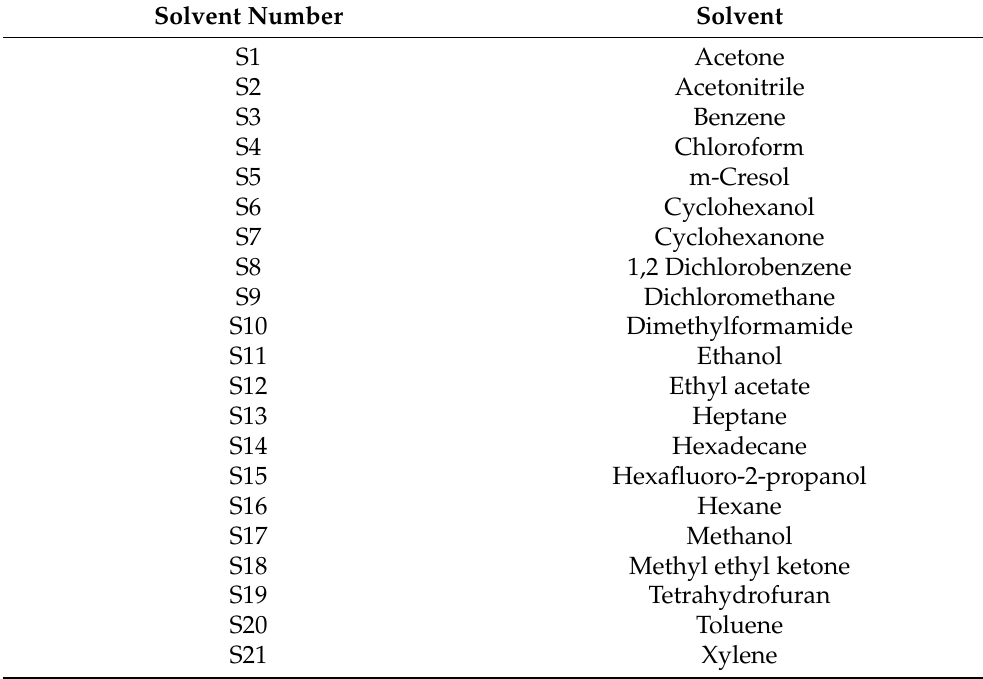
Table 5. List of solvent numbers relevant to Figure